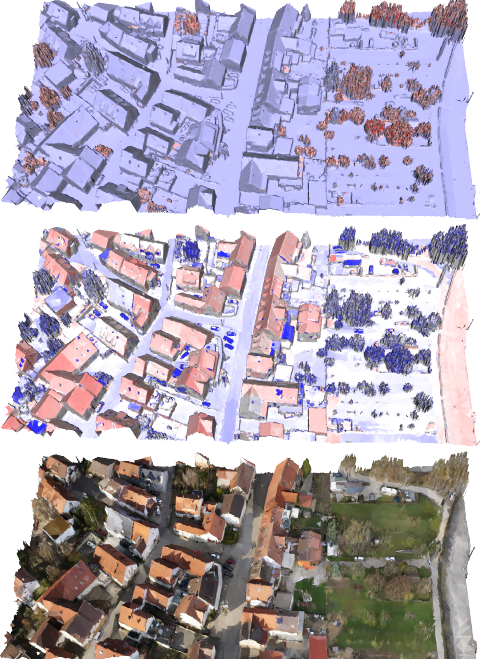
Figure 2. Per-face features (top: median return number , center: median intensity , bottom: median RGB ). Blue indicates low values; red high values.